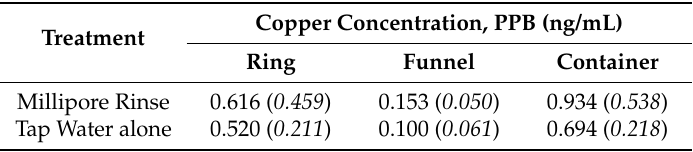
Table 3. Copper in artificial urine after sitting on metabolic cage collection